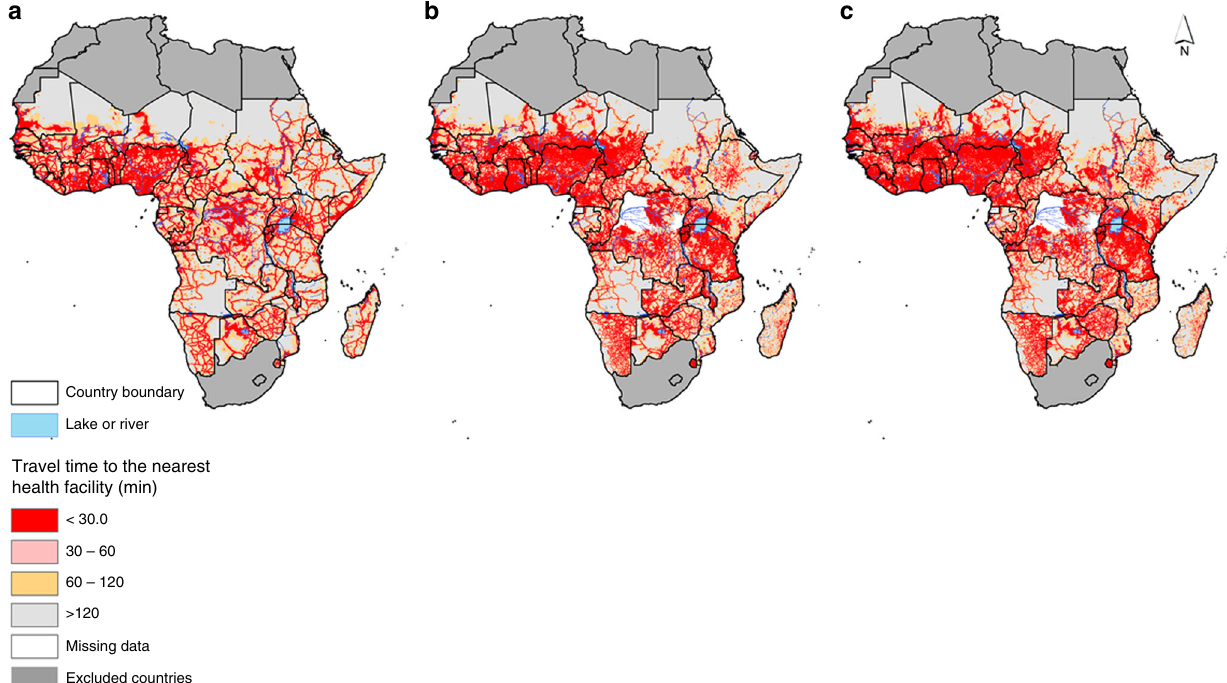
Fig. 2 Travel time maps. Travel time to the nearest health facilities at 1 km spatial resolution in sub-Saharan Africa based on combined motorised transport and walking, adjusting for topography for a major general hospitals, b health centres and c dispensaries, clinics and health posts (lower-tier health facilities). The white patches are regions where health centre or dispensary maps were unavailable (the Congo, Equatorial Guinea, Guinea Bissau and two regions in the Democratic Republic of Congo